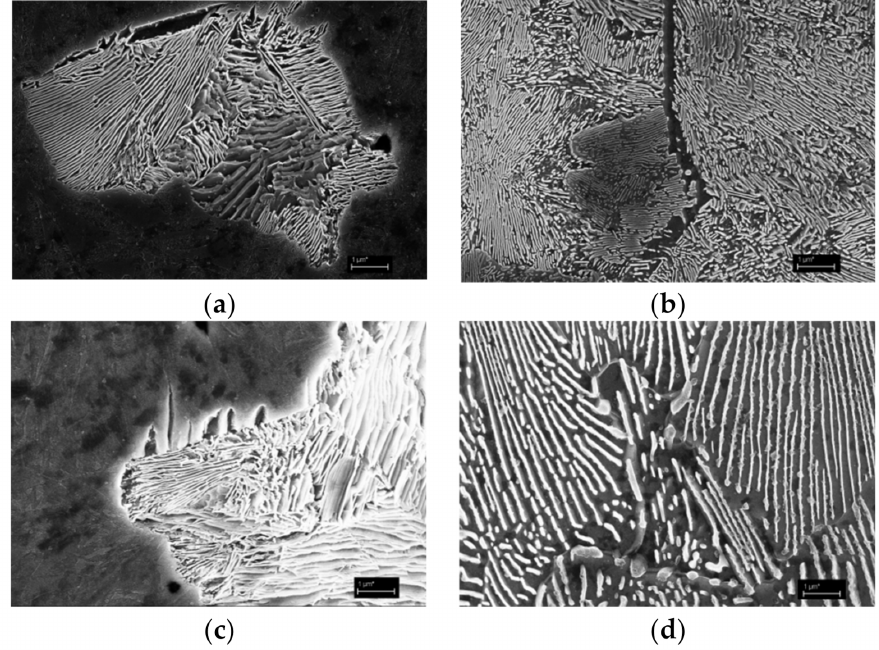
Figure 2. SEM microstructure near the grain boundary in the specimens at various temperature and times: ( a ) 607 ◦ C—5 s; ( b ) 607 ◦ C—180 s; ( c ) 707 ◦ C—5 s; ( d ) 707 ◦ C—300